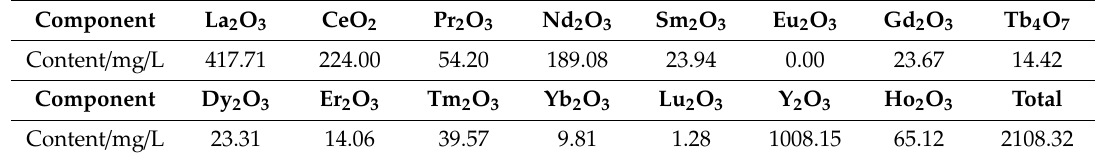
Table 4. REE compositions of the concentrate by ICP analysis.